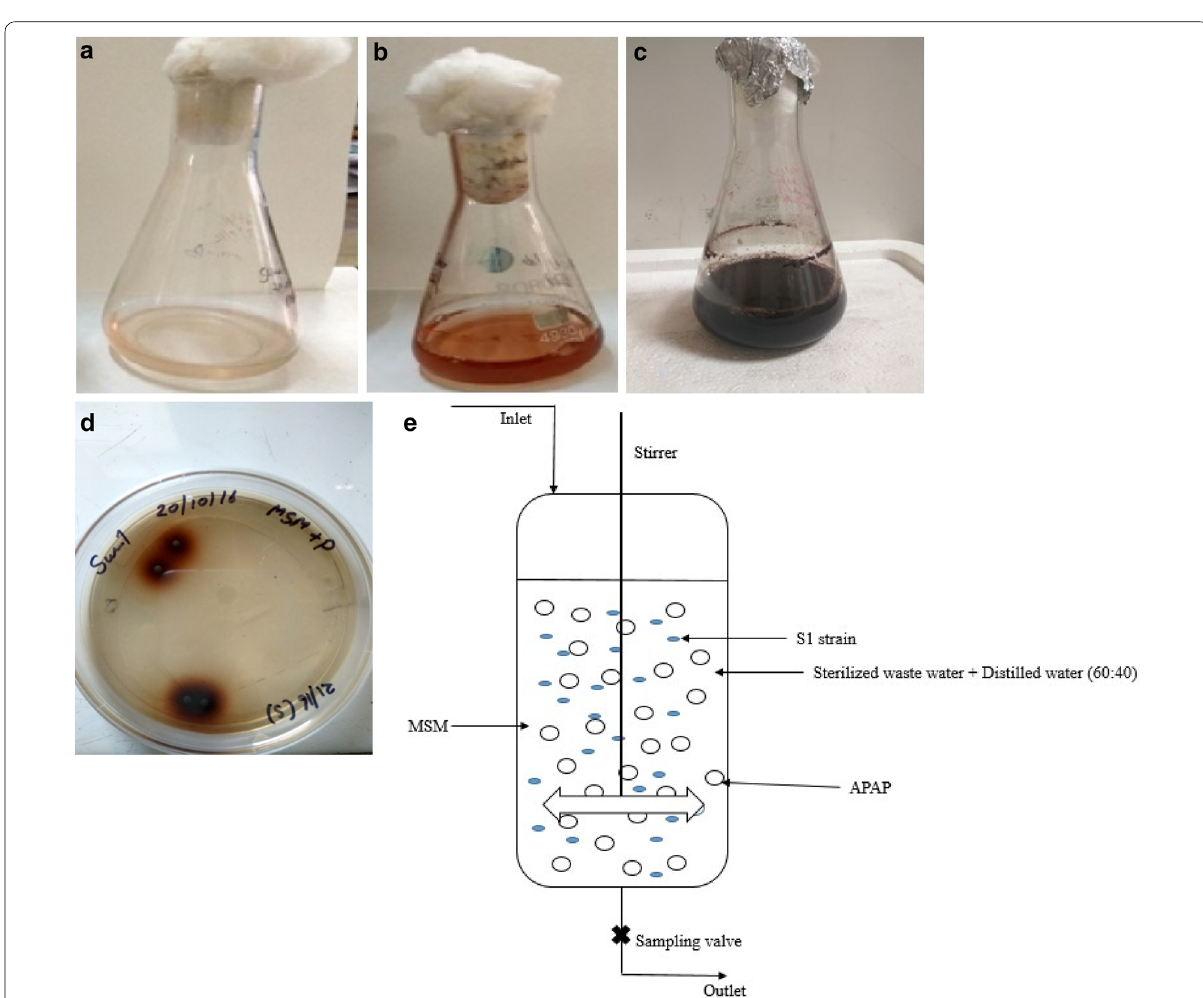
Fig. 1 Biodegradation of APAP by bacterial strain S1 using batch culture study and morphology of the colony observed after 48 h on plate containing mineral salt medium (MSM) containing APAP. a The strain S1 inoculated with BHM and supplemented with 5 mg/mL of APAP; b after 48 h of incubation of the culture the appearance of the medium changes from colorless to light brown; c similarly after 5 days of incubation the color changed from light brown to black; d morphology of the colony observed after 48 h on plate containing mineral salt medium (MSM) containing APAP, e pilot-scale anaerobic reactor used for biodegradation of